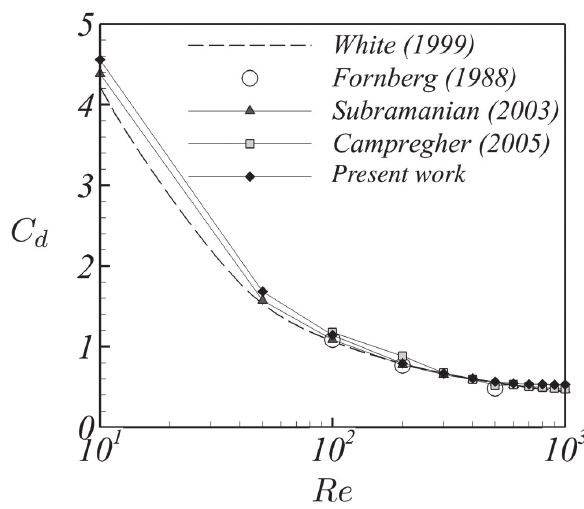
Figure 19 - Drag coefficient as a function of the Reynolds number: Re = 10 up to Re = 10 3 (Fornberg 1988, White 1999, Subramanian 2003, Campegher